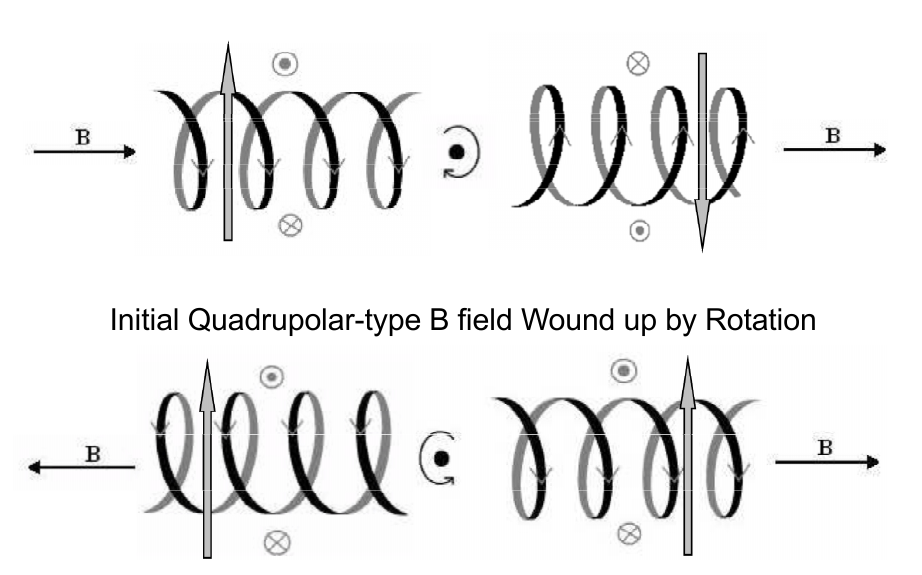
Figure 5. Illustration of the toroidal B -field components arising when the parts of the dipolar and quadrupolar fields near the axis are wound up by rotation of the central black hole. The arrows labeled “B” indicate the initial axial B -field directions before being wound up, the circles with an x or dot inside indicate the direction of the resulting toroidal field, into and out of the page, respectively. The gray arrows indicate the direction of the resulting systematic Faraday rotation gradient across the jet due to the toroidal field component.